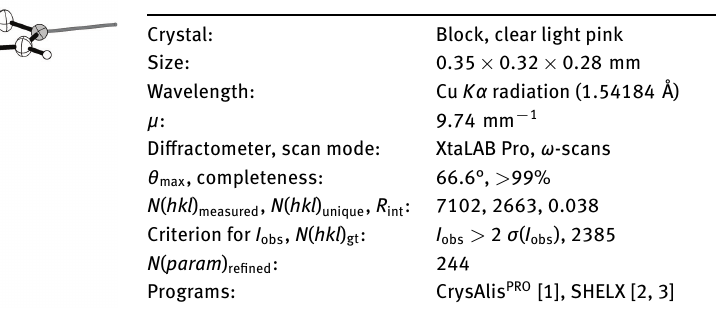
Table 1: Data collection and handling.